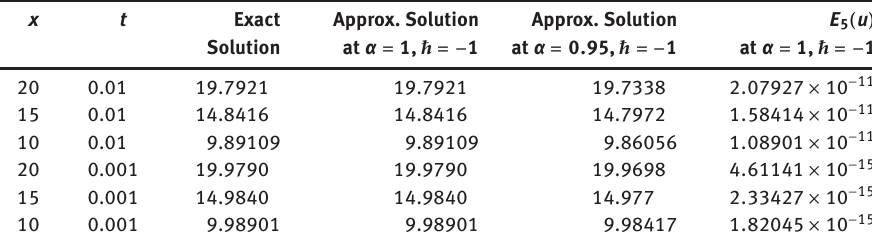
Table 1. Comparison study between the exact and approximate solution at 5th term approximations with error estimation.